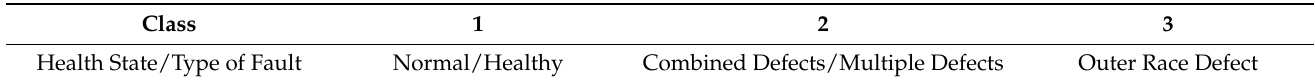
Table 2. Bearing defect classes for case study-1.